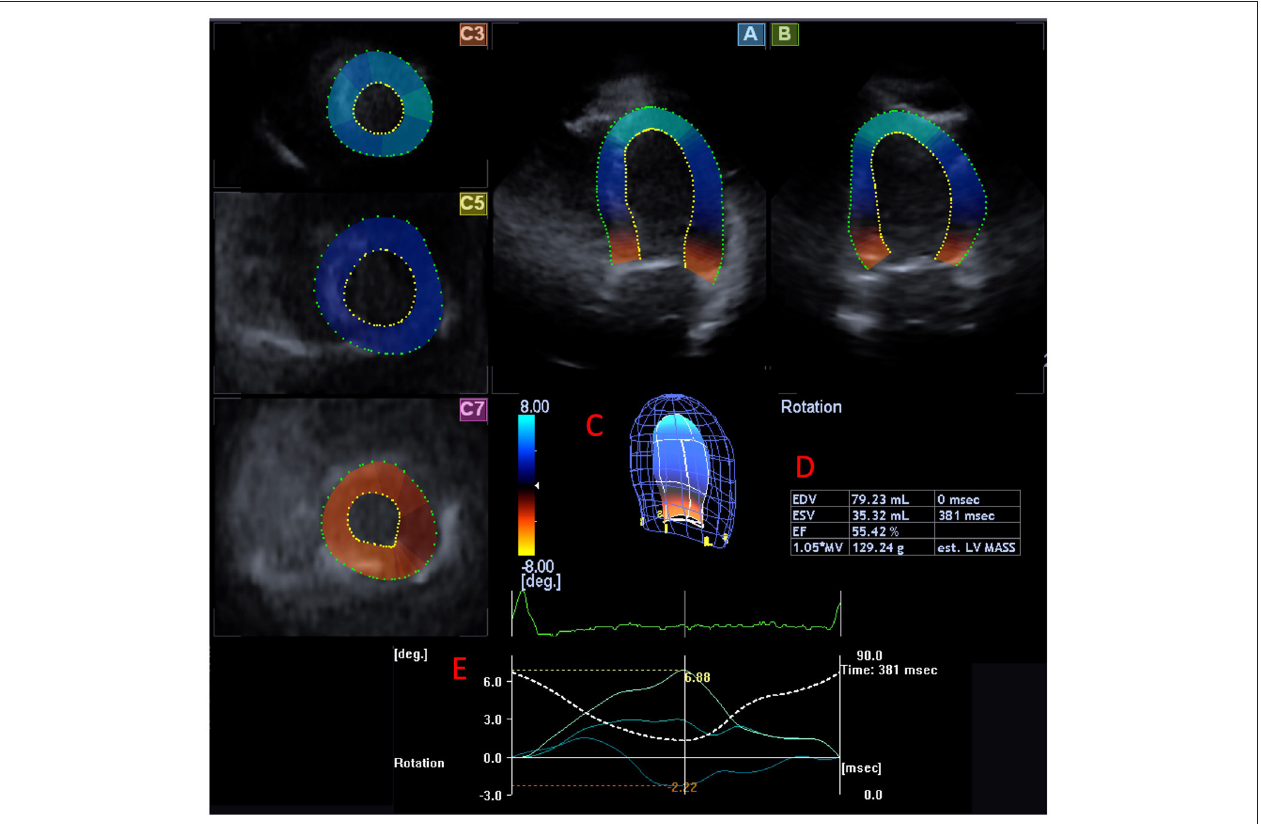
FIGURE 1 | Three-dimensional (3D) speckle-tracking measurement of left ventricular (LV) rotational mechanics from an LV focused view in a patient with hypopituitarism is presented. Apical four-chamber (A) and two-chamber views (B) and apical (C3), midventricular (C5), and basal (C7) short-axis views are presented extracted from the acquired 3D volumetric dataset are presented. (C) Shows the software-generated LV cast, while (D) presents LV volumetric parameters. (E) Section shows the LV rotation curves and corresponding peak values at the apical, midventricular, and basal LV levels (colored lines). Dashed line represents LV volumetric changes during the cardiac